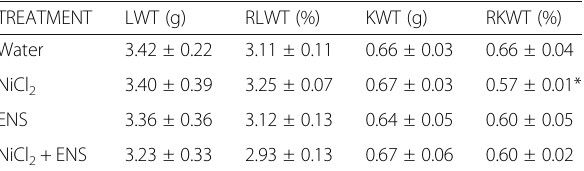
Table 1 Organ weight and relative organ weight in test and control